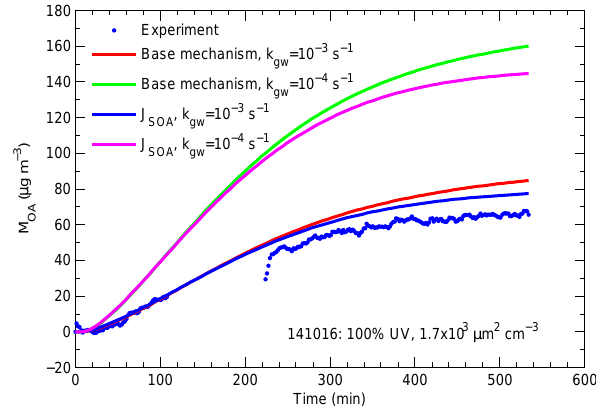
Figure 7. Mass of SOA as a function of time for one 100% UV experiment. Experimental data are shown with filled circles. Solid lines show GECKO-A predictions with and without condensed- phase photolysis with two different vapor wall loss